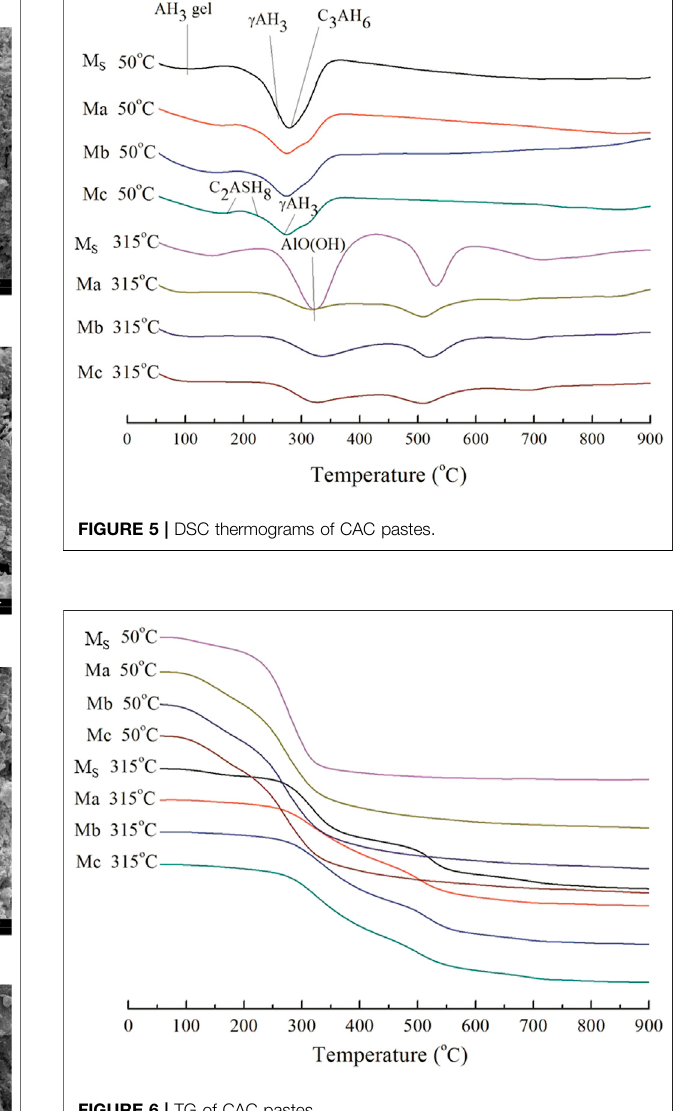
FIGURE 6 | TG of CAC